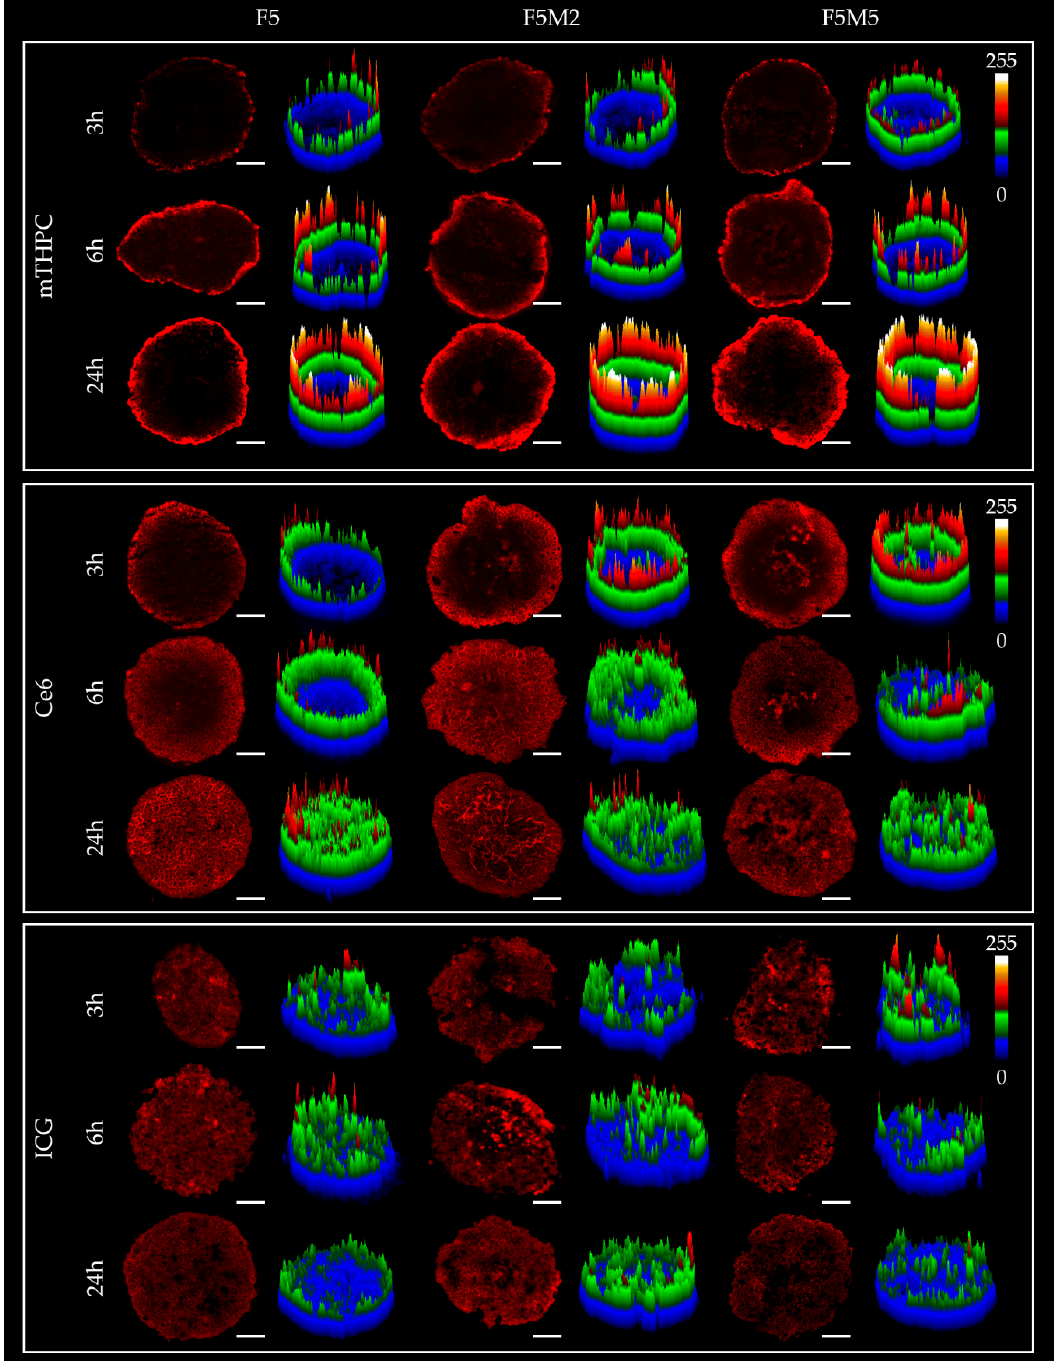
Figure 4. The typical fluorescence images of cryosections of FaDu monoculture (F5) and FaDu:MeWo (5:2 and 5:5) spheroids at 5 day post-seeding after incubation with mTHPC, Ce6 (4.5 µM) and ICG (40 µM) for 3, 6 and 24 h. mTHPC fluorescence is displayed in red-color (2D images) and pseudo-colors (3D surface plots).